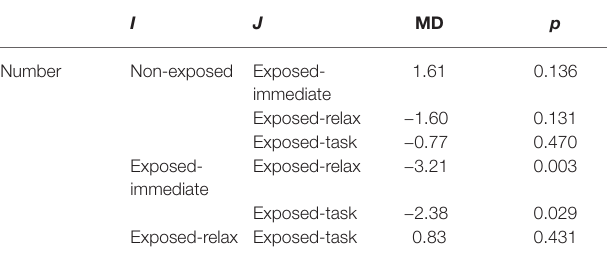
TABLE 3 | Post hoc multiple comparisons of ideas generated in total 20 min (Experiment